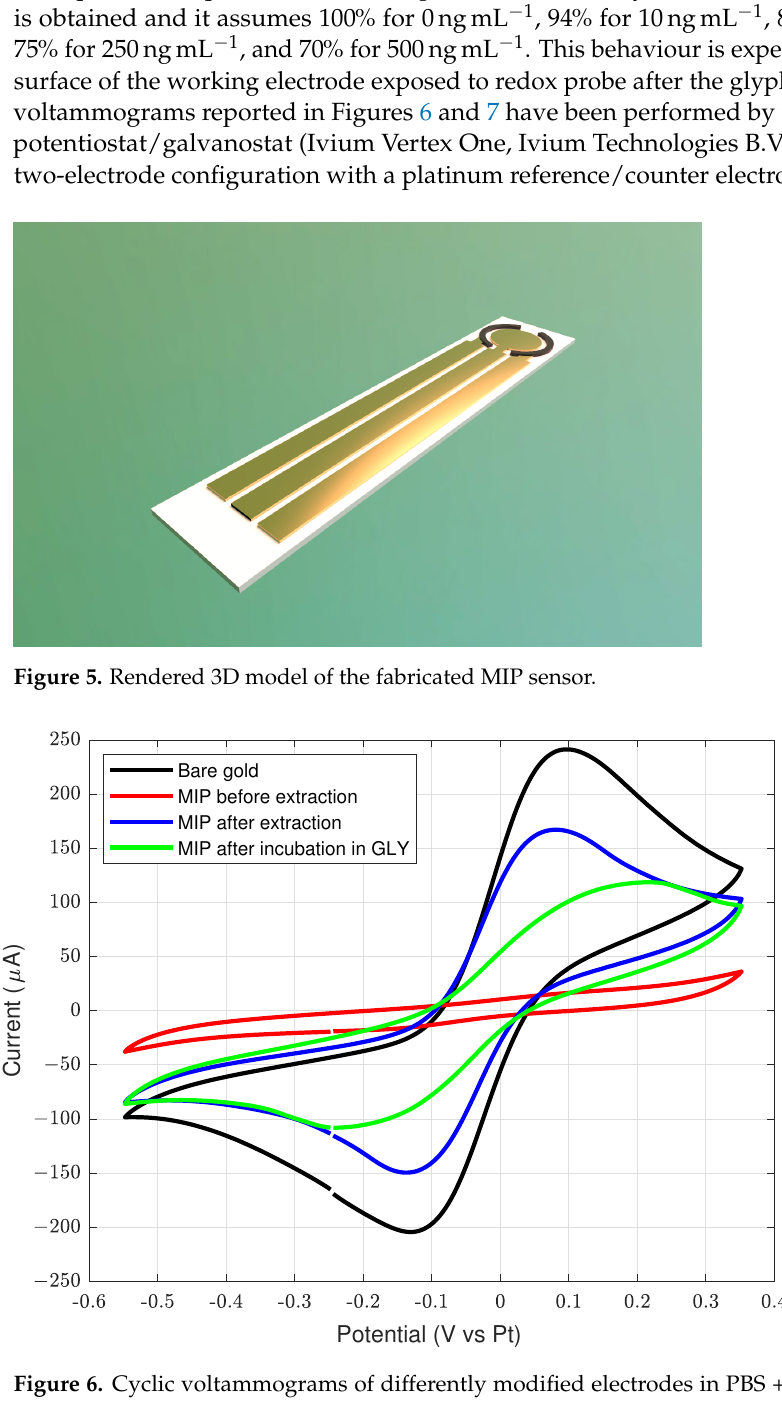
Figure 6. Cyclic voltammograms of differently modified electrodes in PBS + redox probe. (black) the bare gold electrode, (red) MIP modified gold electrode after elution, (blue) MIP modified gold electrode after elution, (green) MIP modified gold electrode with bound glyphosate. In the latter, the used concentration is 500ngmL − 1